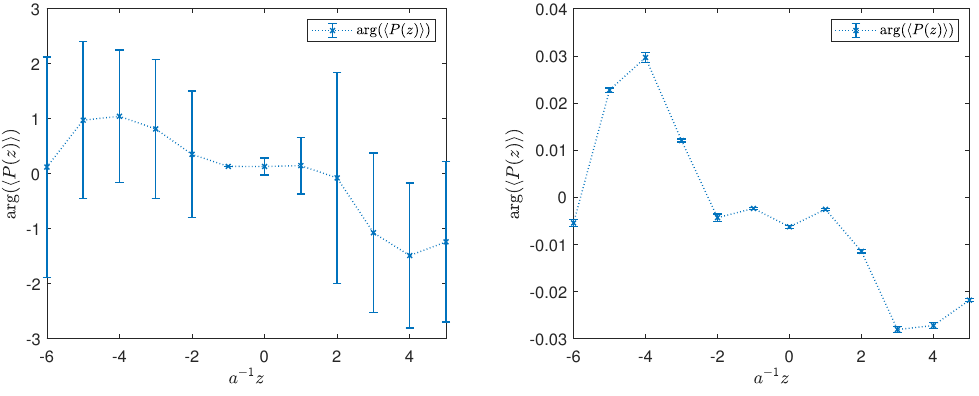
Figure 24 . Same as figure 21 but for β = 5 . 4 (the left panel) and β = 5 . 64 (the right